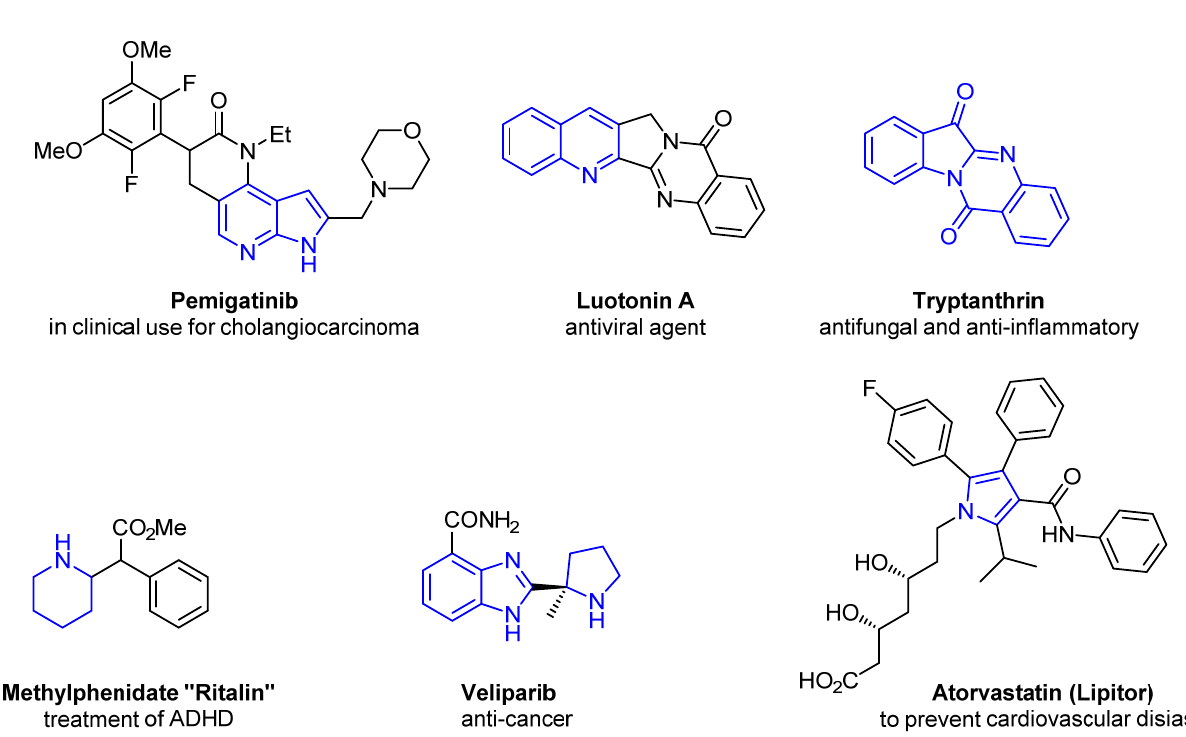
Figure 1 . Representative examples of bioactive saturated and unsaturated N-heterocycles. Figure 1. Representative examples of bioactive saturated and unsaturated N